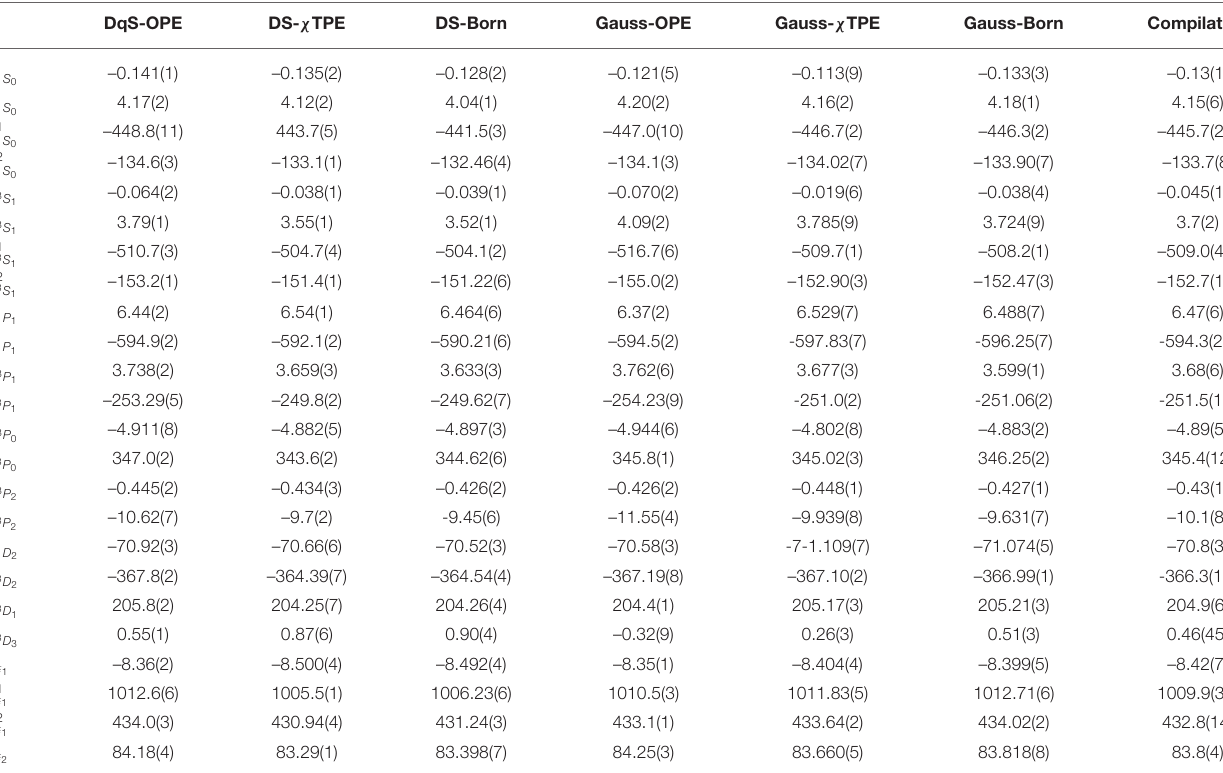
TABLE 9 | Potential integrals in different partial